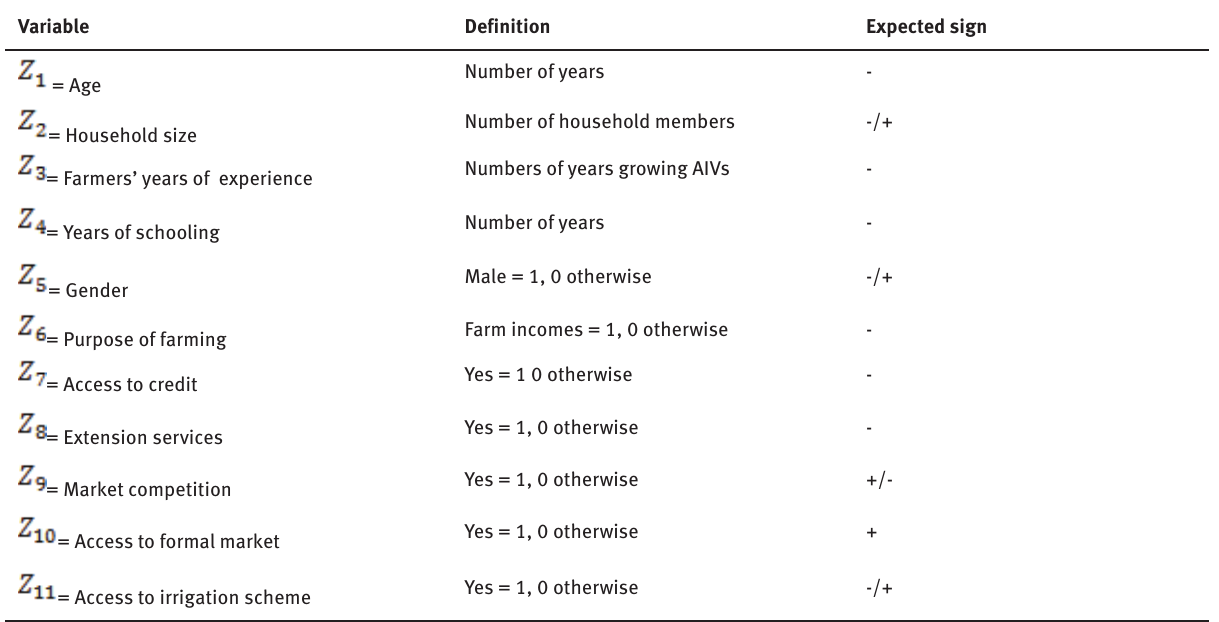
Table 2: Description of inefficiency independent variables